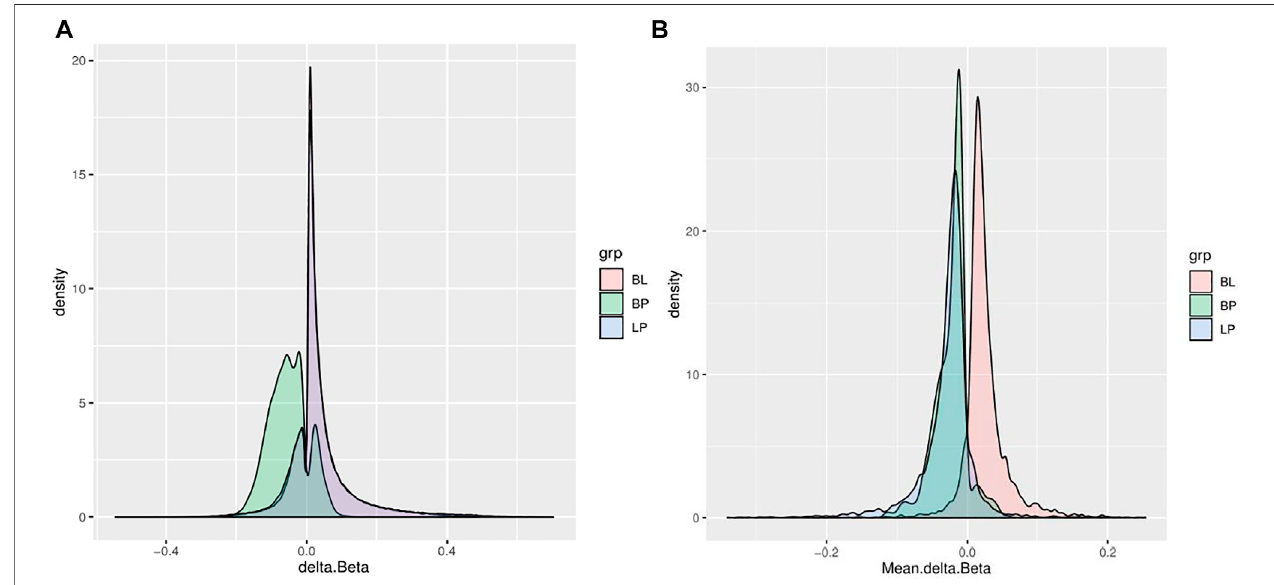
FIGURE 4 | Probability density functions for the effect size between groups. These distributions are useful for selecting cutoffs for differential methylation. (A) Differences in beta values for differentially methylated probes. (B) Differences in mean delta beta for differentially methylated regions. BP, Comparison of buffy coat to polymorphonuclear leukocytes: BL, Comparison of buffy coat to lymphocytes; PL, Comparison of polymorphonuclear leukocytes to lymphocytes.